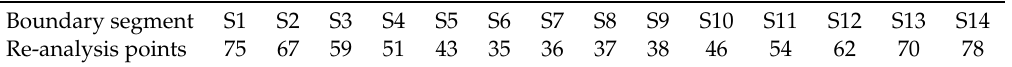
Table 1. Correspondence among segments and re-analysis